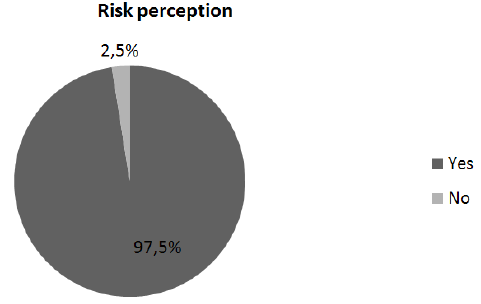
Fig. 9. Risk perception frequency